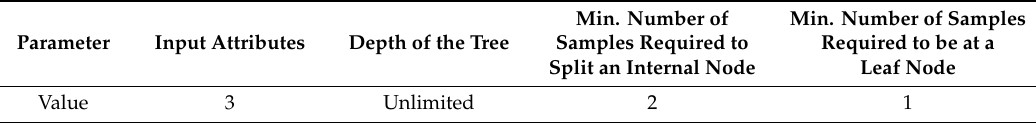
Figure 5. Schematic diagram of decision tree algorithm. Table 2. Parameters for decision tree model.